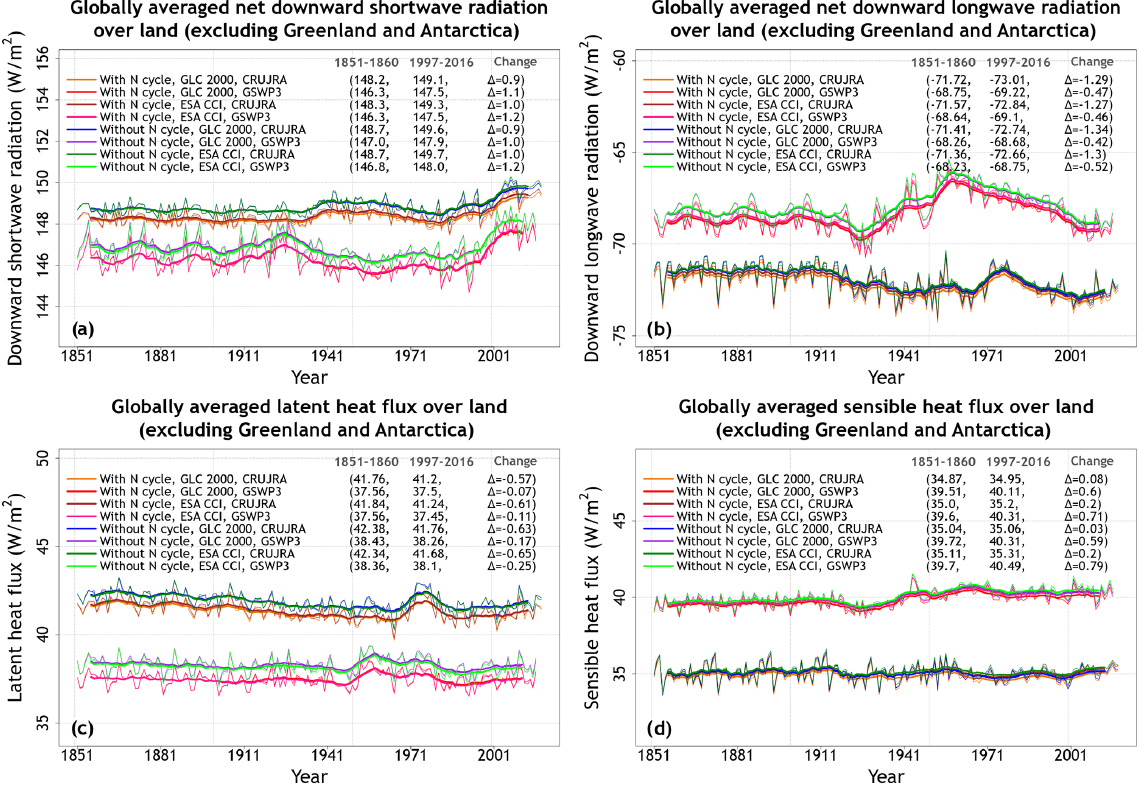
Figure A4. Time series of simulated globally averaged annual energy fluxes from the eight simulations summarized in Table 1; (a) shows net downward shortwave radiation, (b) shows net downward longwave radiation, (c) shows latent heat flux, and (d) shows sensible heat flux. The thin lines show the individual years, and the thick lines show their 11-year moving average. Model values averaged over the pre-industrial (1851–1860) and present-day (1997–2016) time periods, and their difference, are also shown for individual simulations.